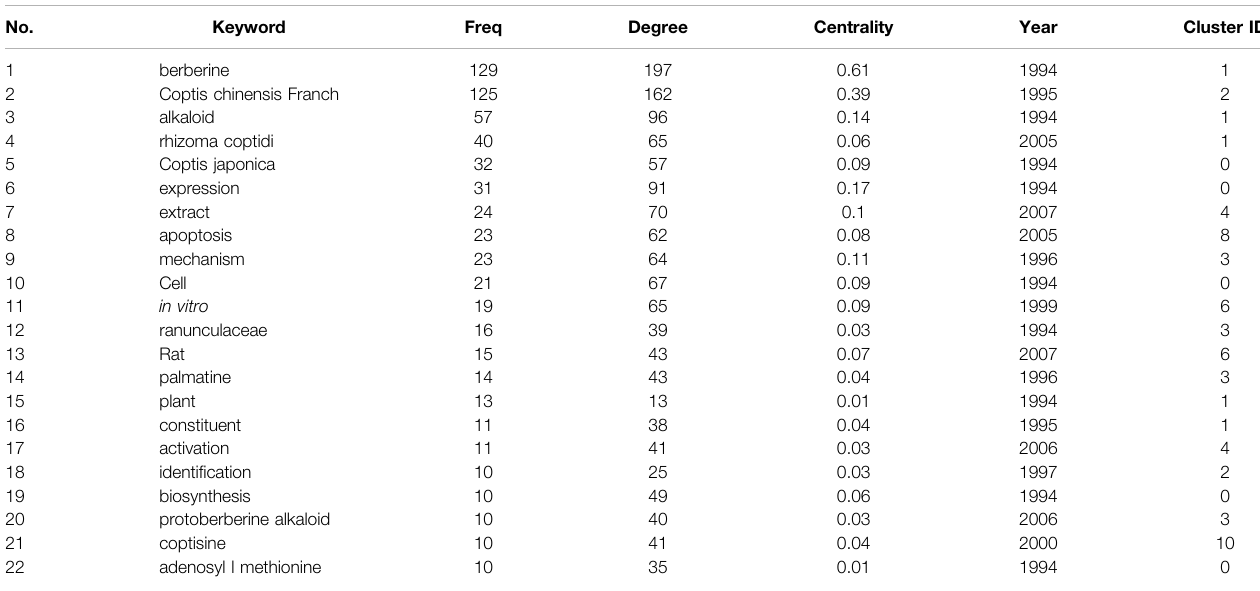
TABLE 4 | Keywords that appeared at least 10 times in Coptis